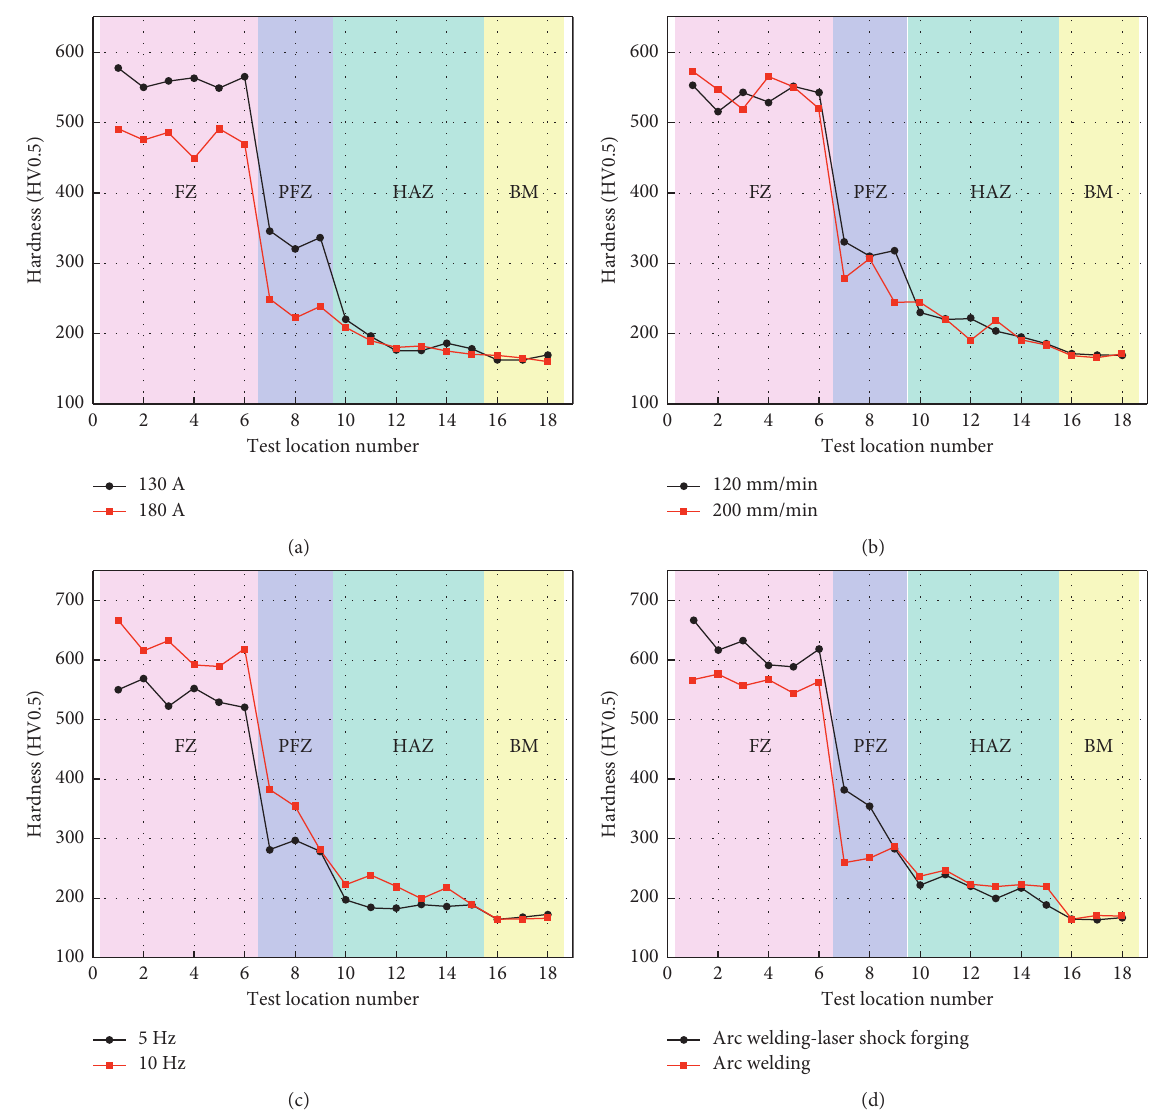
Figure 6: (a–c) Effects of AW-LSF parameters on the hardness profiles of the weld beads for FZ, PFZ, HAZ, and BM. (a) Welding current. (b) Welding speed. (c) Laser shock frequency. (d) Hardness distribution profile of the weld seam of the AW (welding current is 130A, and welding speed is 140mm/min) and the AW-LSF (welding current is 130A, welding speed is 140mm/min, and laser shock frequency is